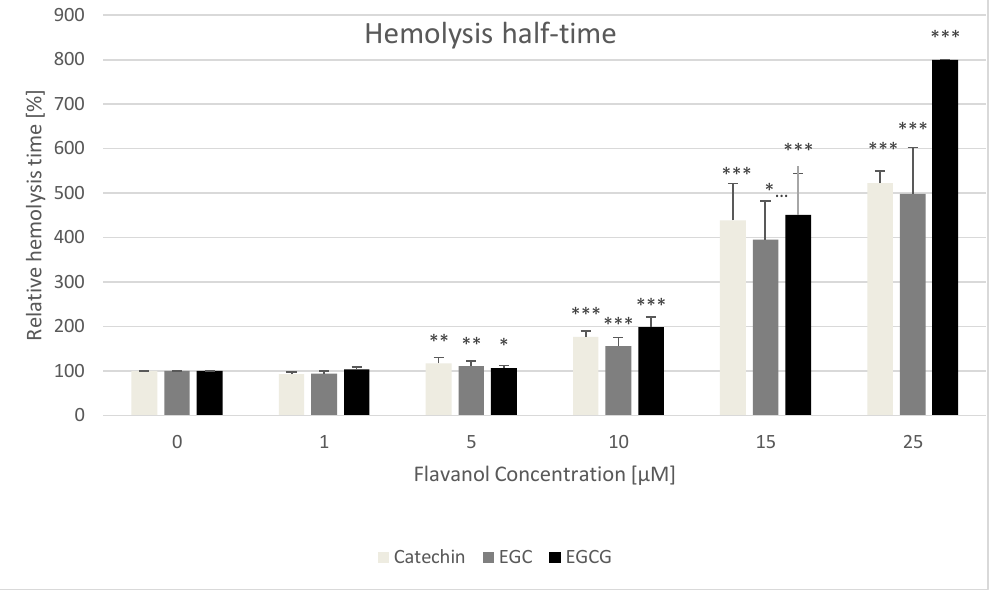
Figure 5. Effect of monomeric flavanols on the relative hemolysis half-time of erythrocytes. Half-time of hemolysis of control samples assumed as 100%. * p < 0.05, ** p < 0.01, *** p < 0.001 (with respect to control).